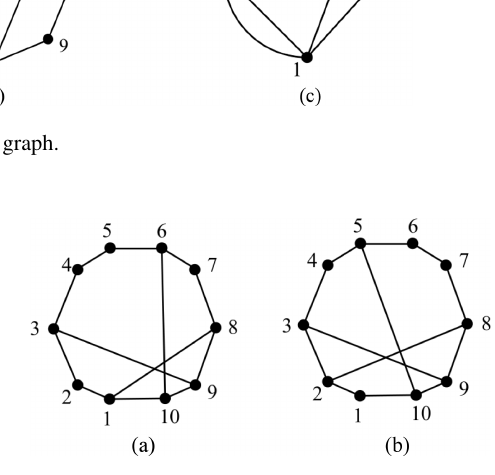
Figure 2. (a) A 10-link PSKC (1) and (b) 10-link PSKC (2).